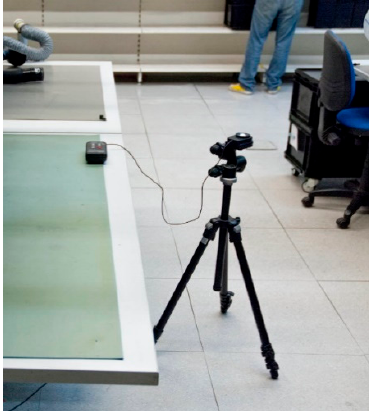
Figure 7. Illuminance measurement procedure in a lighting survey. A T-10a Minolta calibrated illuminance meter was used for the measurements.